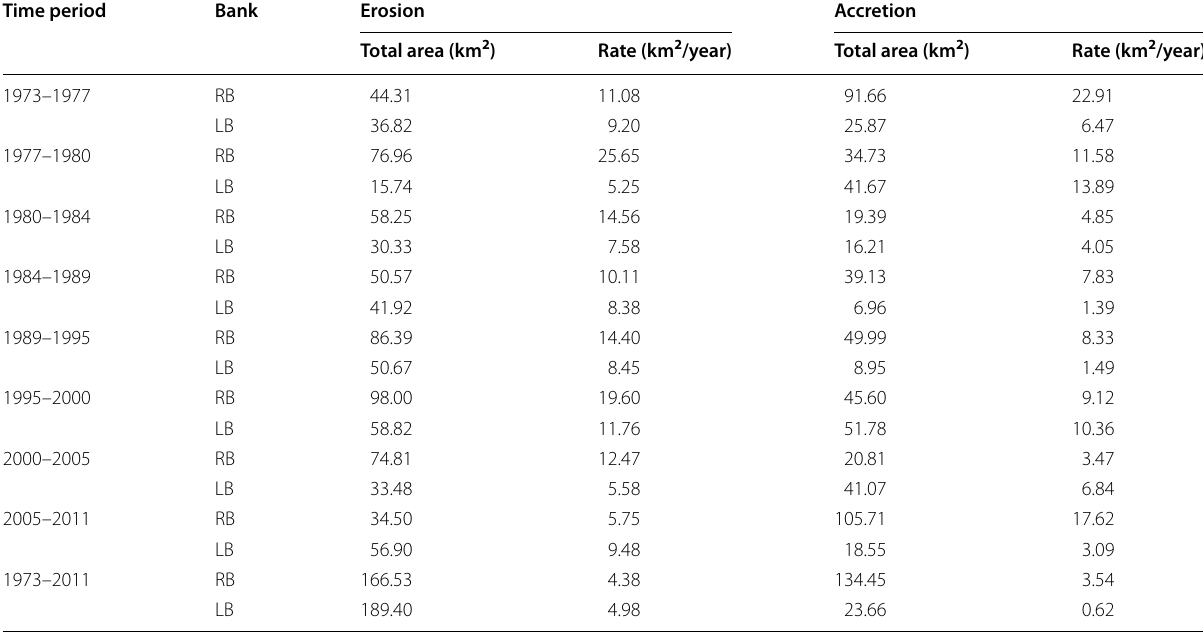
LB left bank, RB right bank